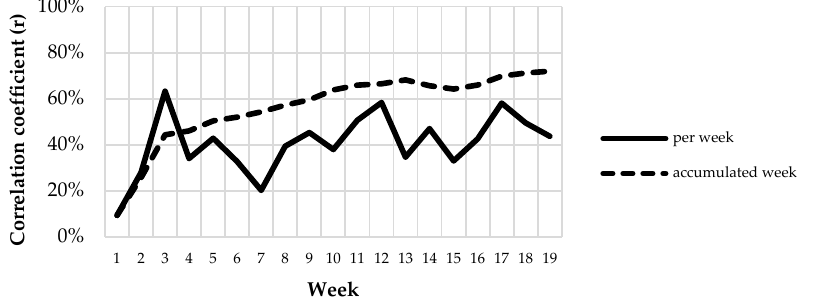
Figure 13. Correlation coefficient between the number of droppings and the number of location fixes per plot, per week and per accumulated week.